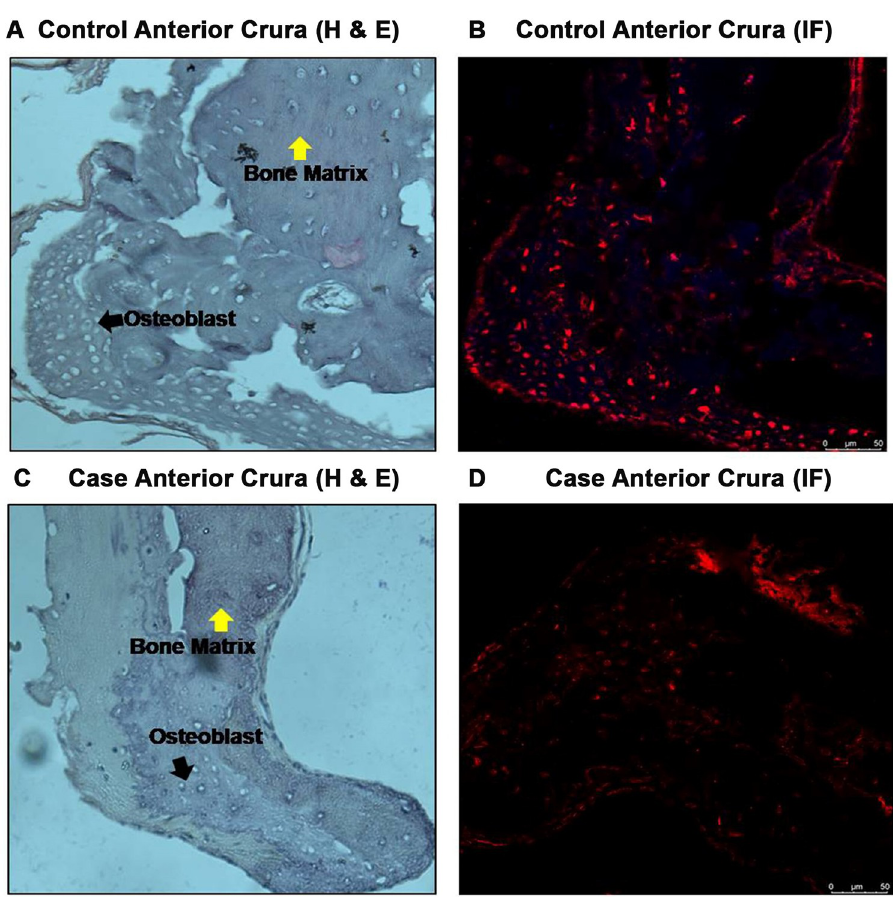
Fig 7. Histological analysis of stapes tissues. Haematoxylin-eosin (A, C) and immunofluorescence staining (B, D) showing the presence of bone cells and expression of reelin protein in stapes tissues from controls and cases. Immunofluorescence assay showed reduced reelin expression in otosclerotic tissues as compared to controls (scale bar = 50 μ m).